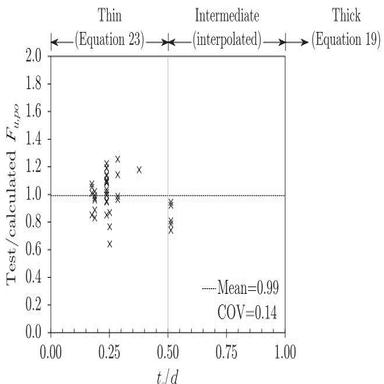
Comparisons between test and predicted Fu,po values for all screwed connections in OSB, calculated using Eq. (23) for cases ts/d⩽0.5 and interpolation between Eq. (23) and the critical value from Eq. for cases when 0.5 < ts/d⩽1.0.